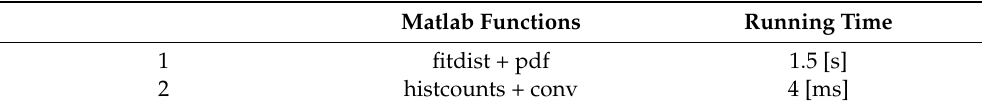
Table 7. Histogram generation